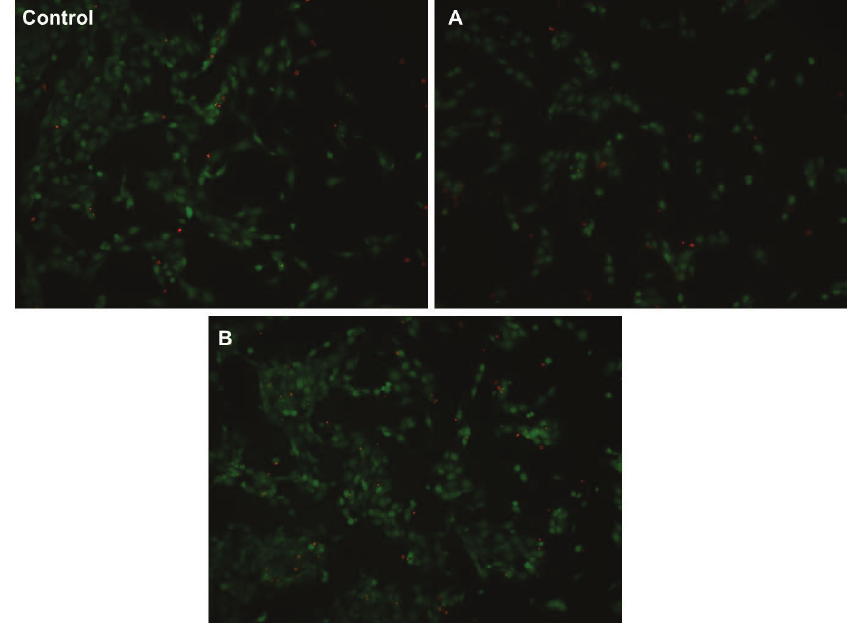
Figure 4. Fluorescence staining of cells cultured on BGNb10 scaffolds: A) 1:2 and B) 1:4 dilution for 24